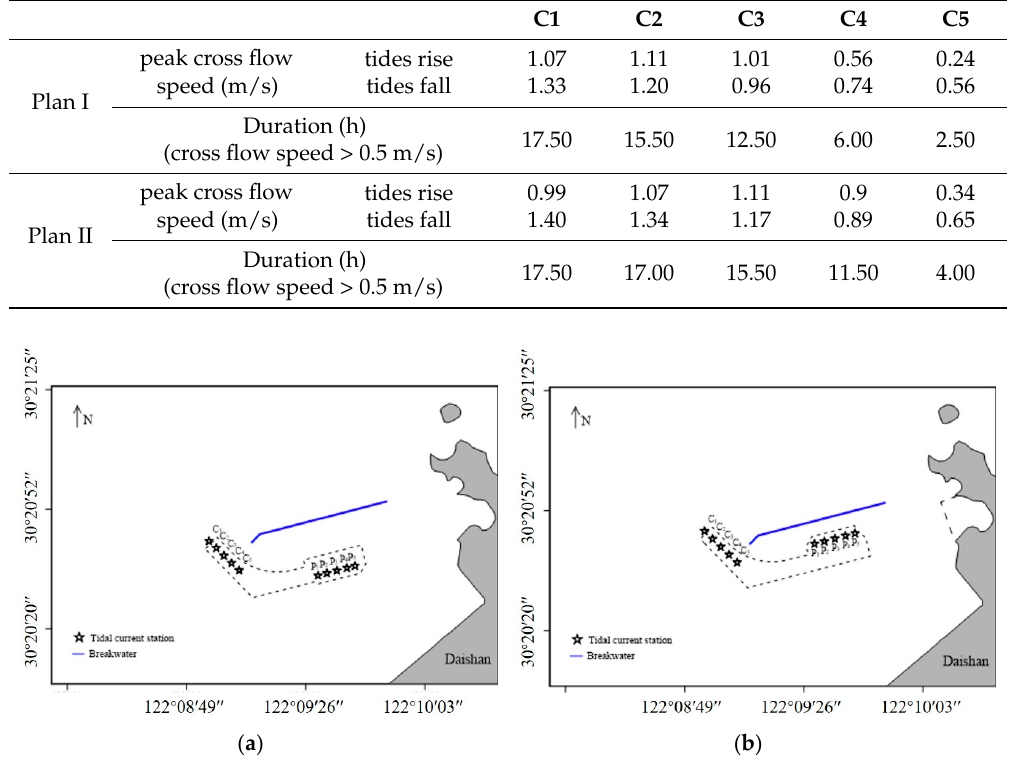
Figure 18. The tidal current station of the entrance of harbor with plan I ( a ) and plan II ( b ). Table 5. Pre-engineering cross flow speed statistics.